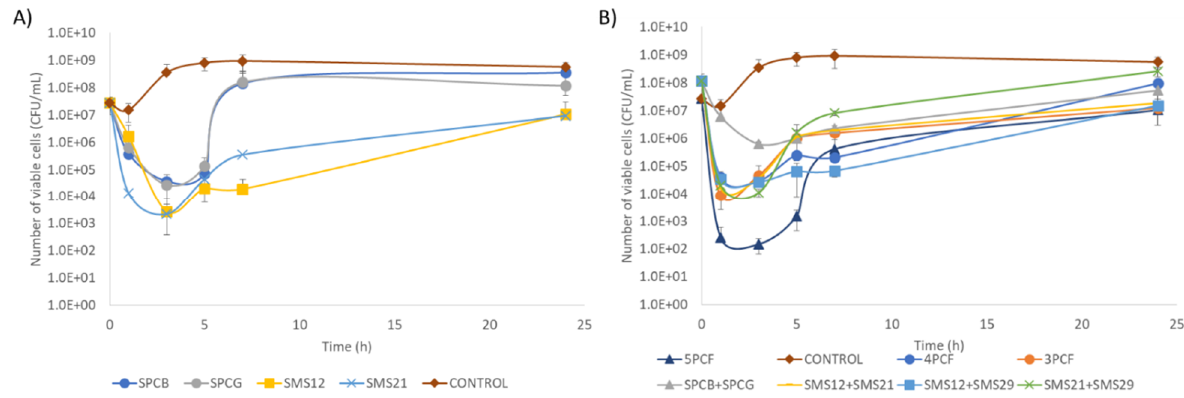
Figure 5. Time–kill experiment of each phage alone or in cocktail against P. aeruginosa PAO1. MOI of 10, 120 rpm, 37 °C: ( A ) phages alone; and ( B ) phages in different cocktail formulations. 5PCF (phages SPCB + SPCG + SMS12 + SMS21 + SMS29); 4PCF (SPCG + SMS12 + SMS21 + SMS29); 3PCF (SMS12 + SMS21 + SMS29). Data are shown as mean ± SD.